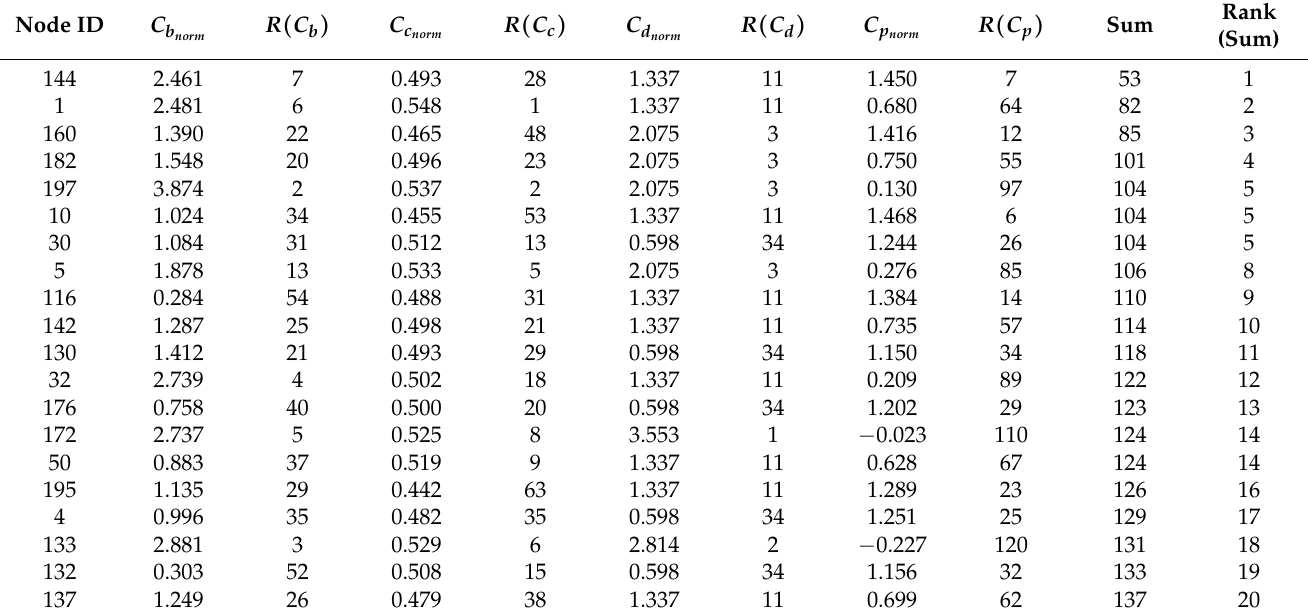
Table 2. Top 20 most critical nodes utilizing the List of Lists approach.